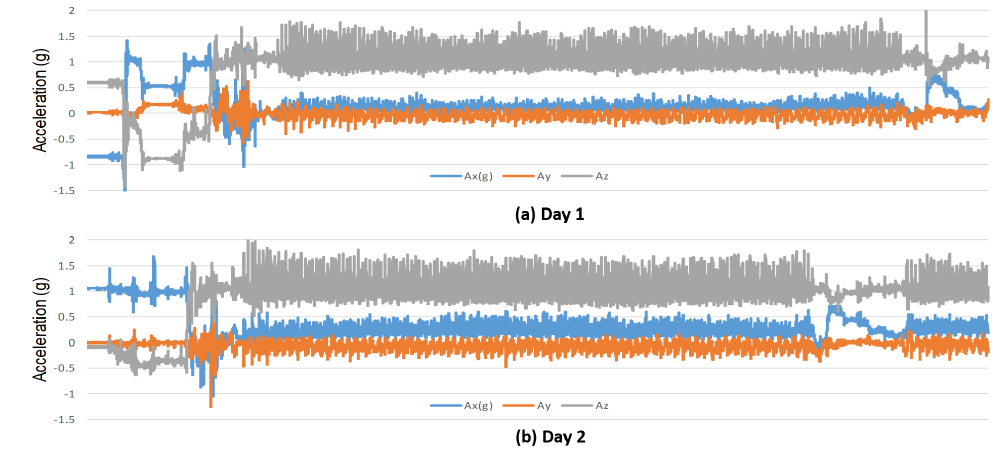
Figure 7. Examples of accelerometer data that appear only in testing.